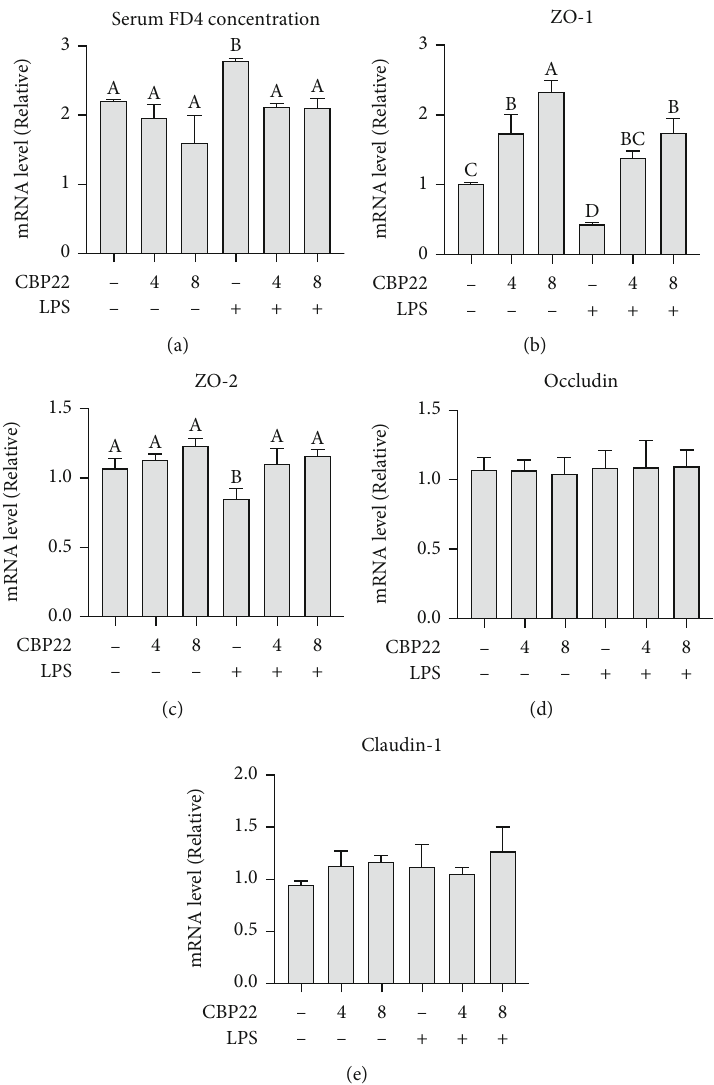
Figure 6: The protective e ff ects of CBP22 on the intestinal barrier. (a) Intestinal permeability is determined by serum FD4 concentration. (b – d) RT-PCR analysis. The mRNA expression of tight junctions and results are presented relative to those of GAPDH, (b) ZO-1, (c) ZO-2, (d) occludin, and (e) claudin-1. The data are expressed as the mean ± SEM , n = 10 biological replicates; bars with di ff erent small capital letters are statistically di ff erent from one